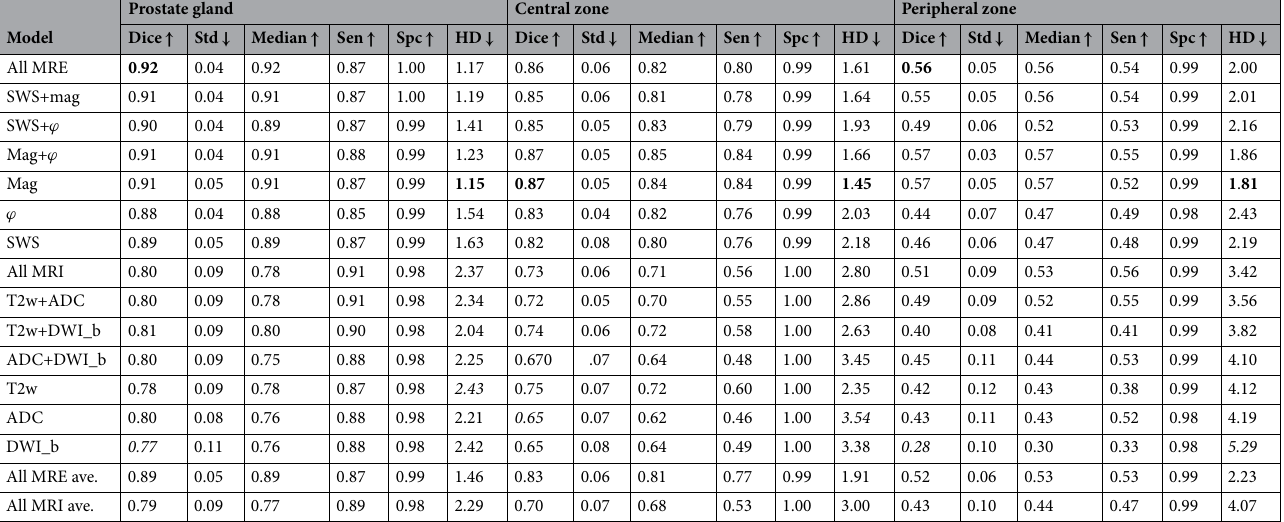
Table 3. Statistical analysis of the segmentation results of the UM. Bold indicates the highest values, while italic indicates the lowest values. ↑ ( ↓ ): the higher (the lower) the better.